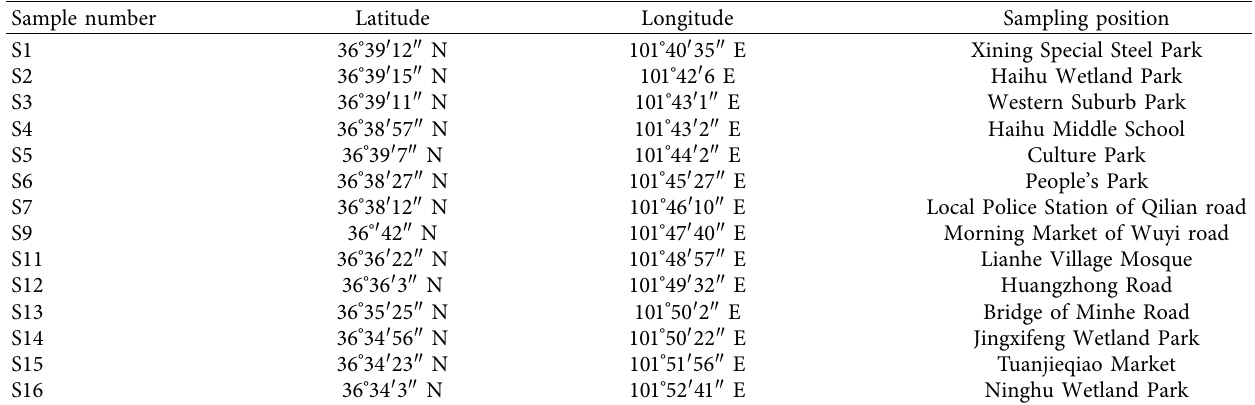
Table 1: Description of sampling points in the Huangshui River.